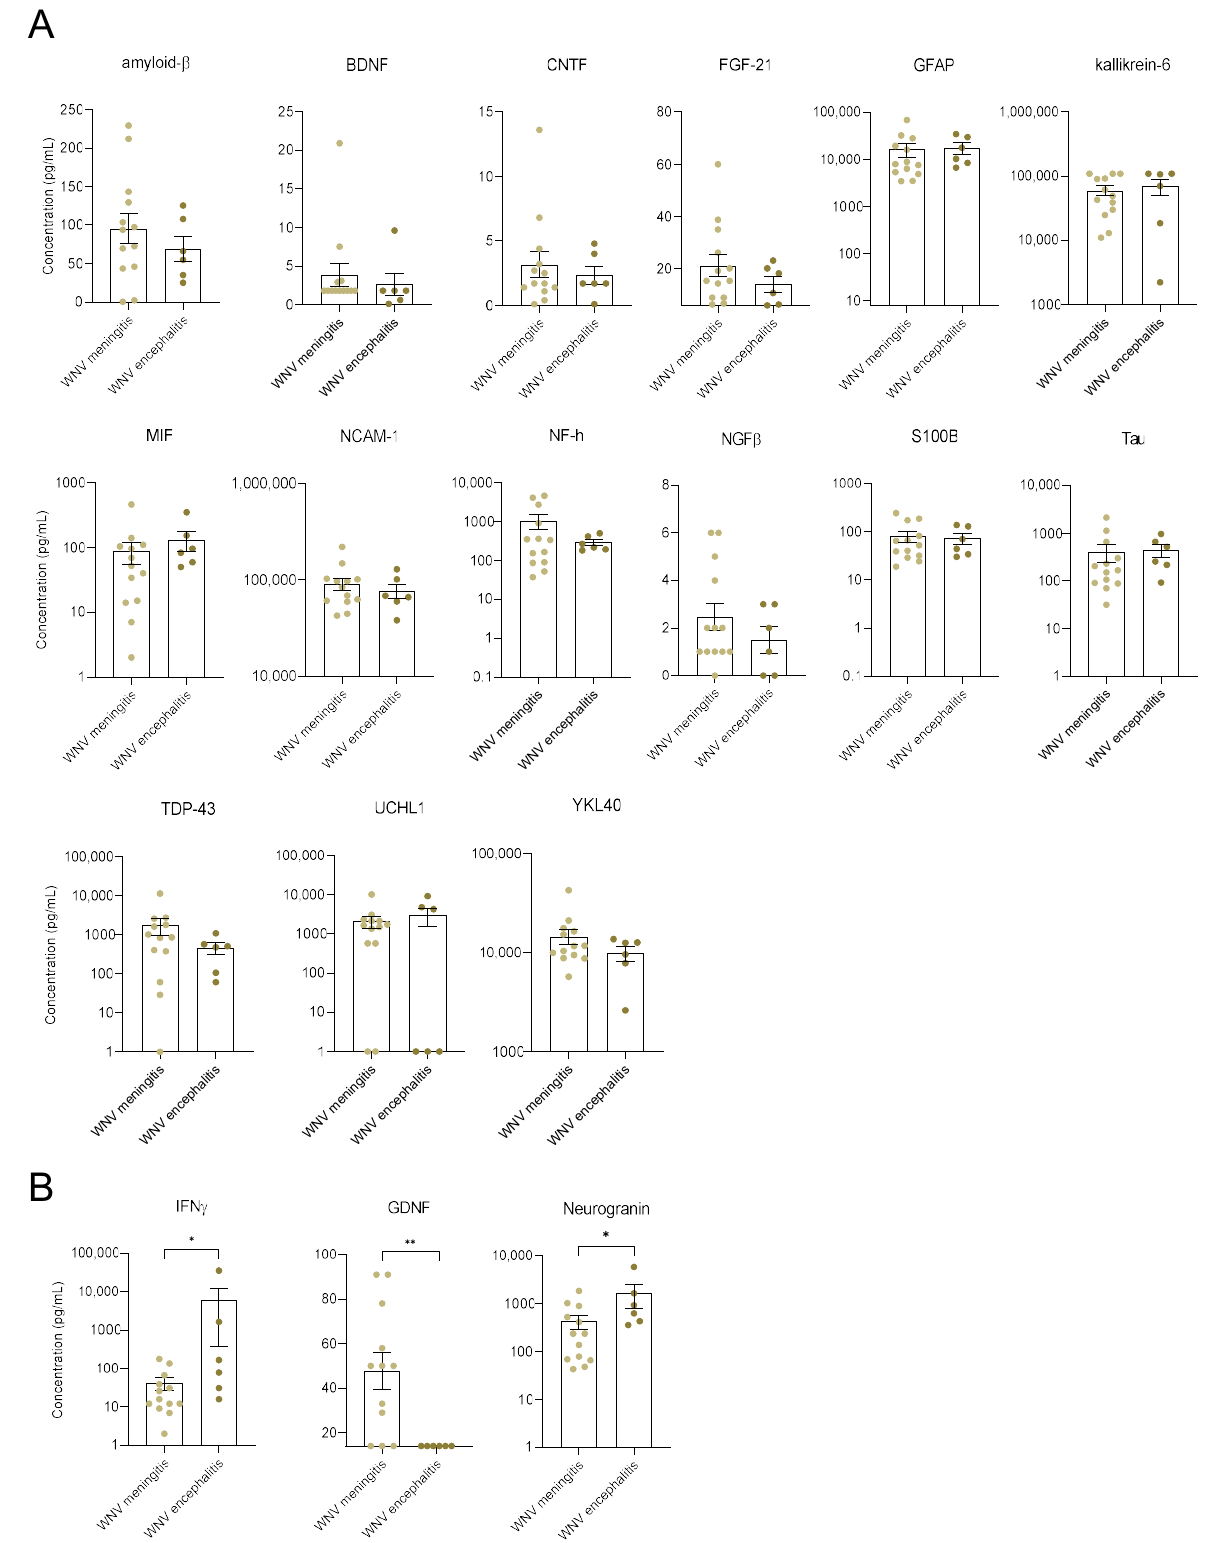
Figure 3. Identification of biomarkers of neuroinflammation in CSF of WNND patients. ( A ) CSF con- centration in pg/mL of different neuronal markers of non-infected CTL (black), WNV-meningitis (yel- low), and WNV-encephalitis (orange) humans, measured by multiplex bead-based ELISA. ( B ) IFN γ , GDNF, and neurogranin are differentially expressed in patients with meningitis and encephalitis. Bars show means ± SEM (* p < 0.05, ** p <